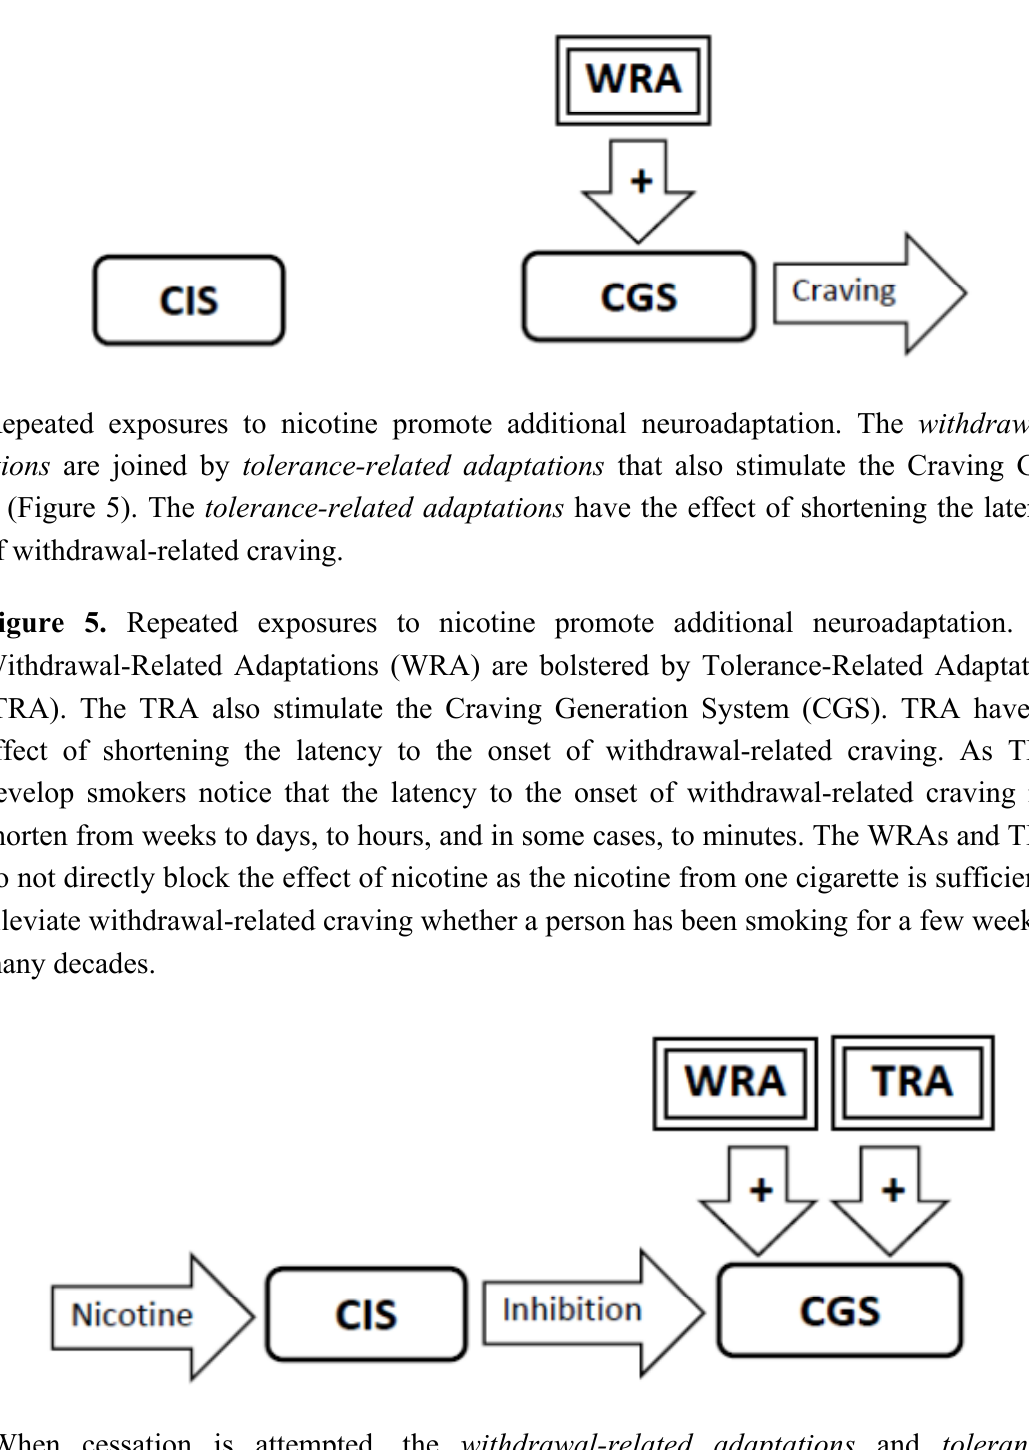
Figure 4. When the down-stream effects of nicotine wear off, the Withdrawal-Related Adaptations (WRA) continue to stimulate the Craving Generation System (CGS) resulting in the spontaneous generation of craving in the absence of smoking cues. This prompts the smoker to smoke every time the effect of nicotine wears off.